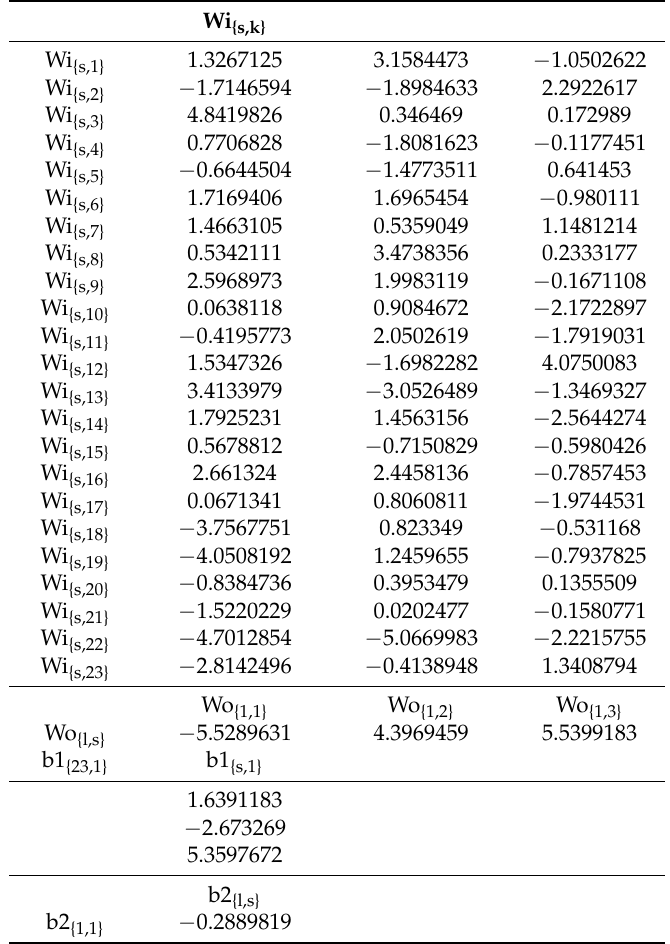
Table A1. Weights and biases for the IP ANN model at birth (3 neurons in the hidden layer, k = 3 and l = 1).